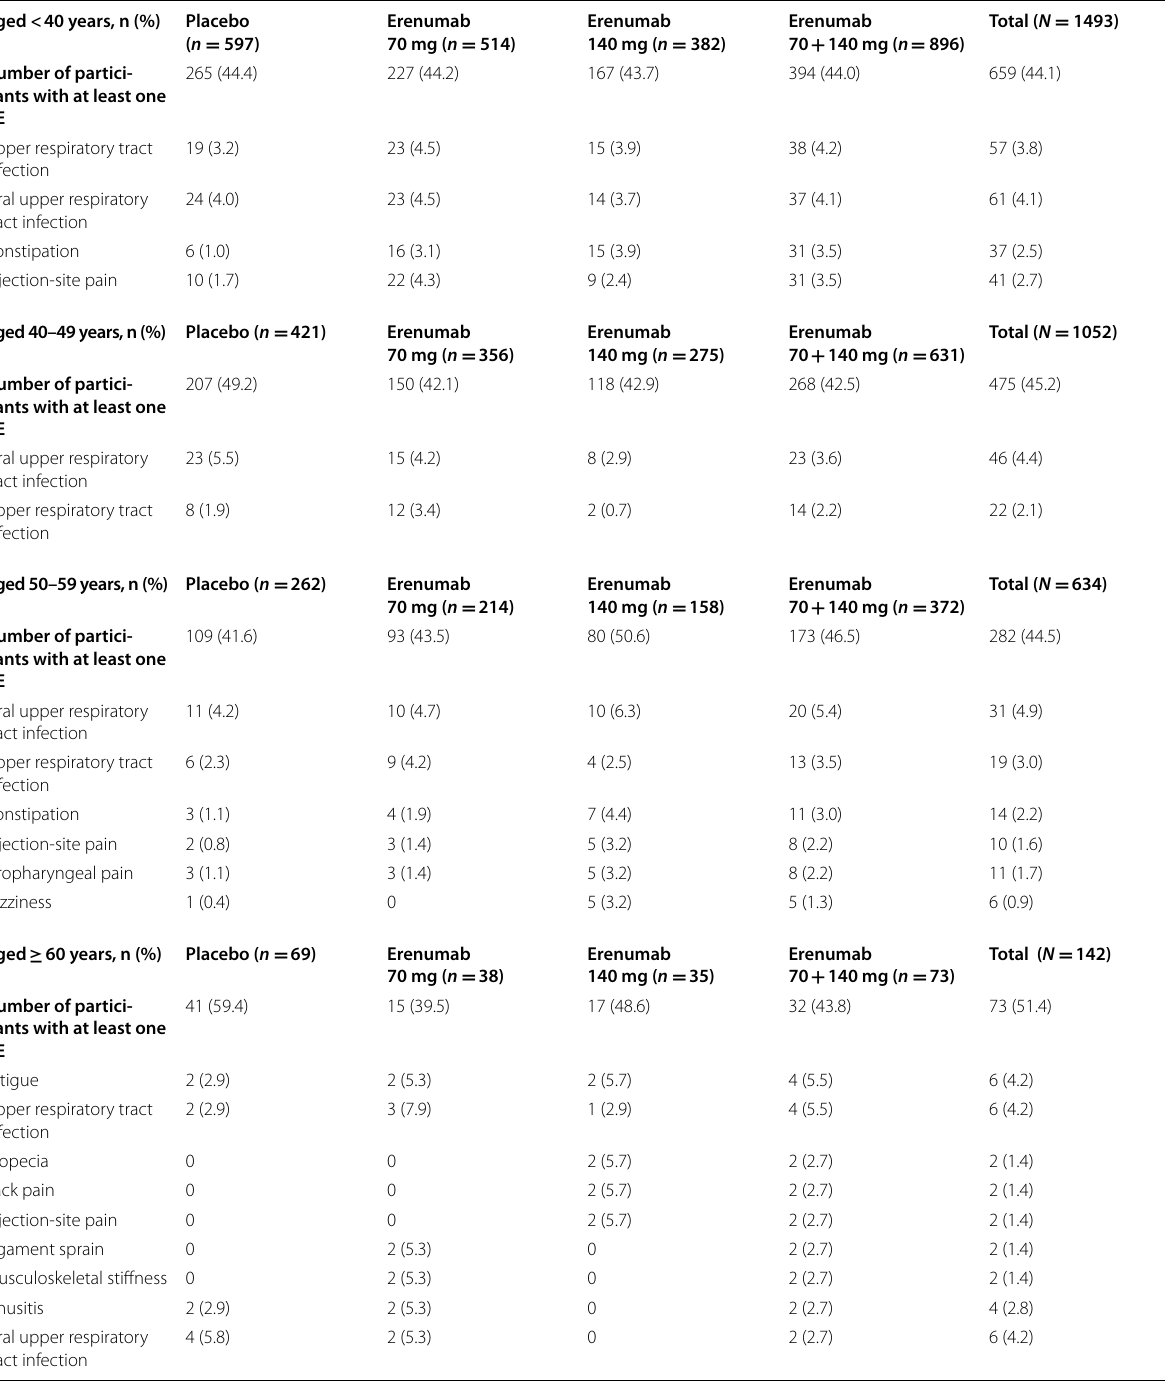
Table 3 TEAEs with incidence of 3.0% in any erenumab group (safety analysis set), by preferred ≥